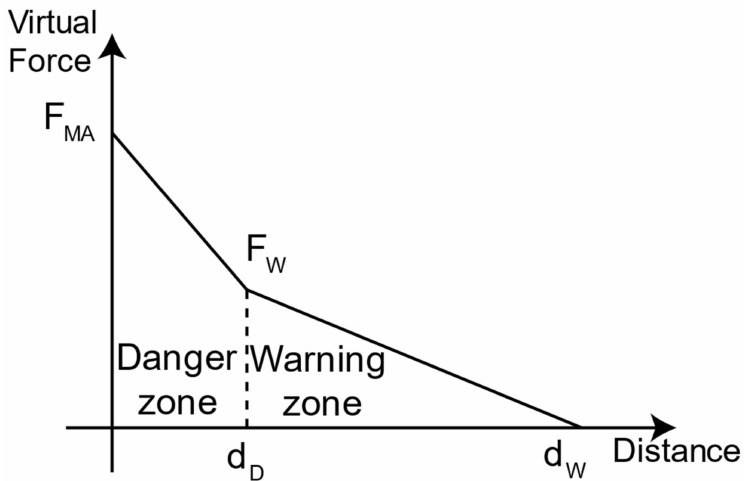
Figure 3. Virtual force generated by an obstacle at a given distance in the environment. The force is proportional to the distance, with different stiffness constants, based on the zone (i.e., “warning” and “danger”